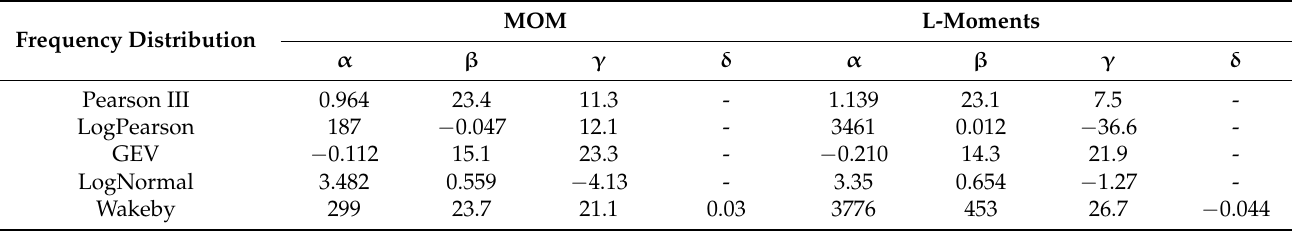
Table 4. Observed data from the Prigor station.